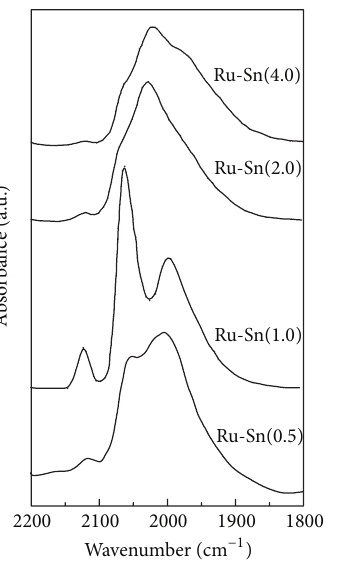
Figure 4: FT-IR spectra of CO adsorbed over the bimetallic catalysts.